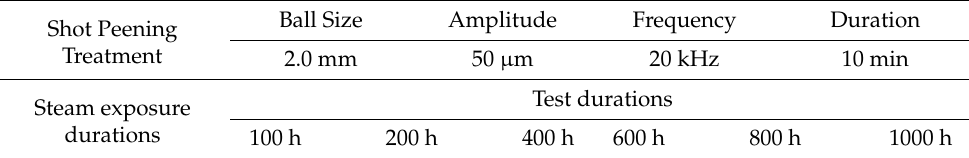
Table 1. Shot peening and steam exposure conditions of T91 specimens.